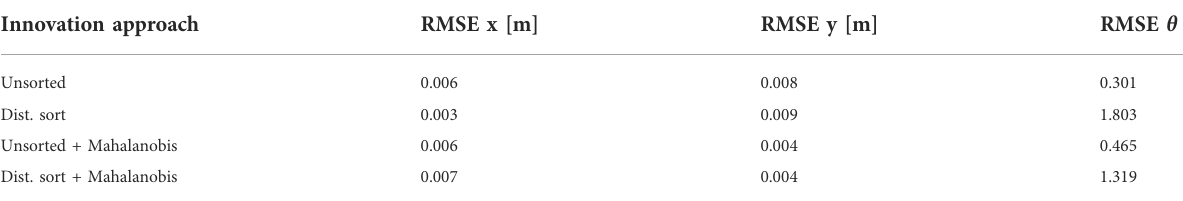
TABLE 5 RMSE from the localization system ’ s kidnapped robot tests — permanent.